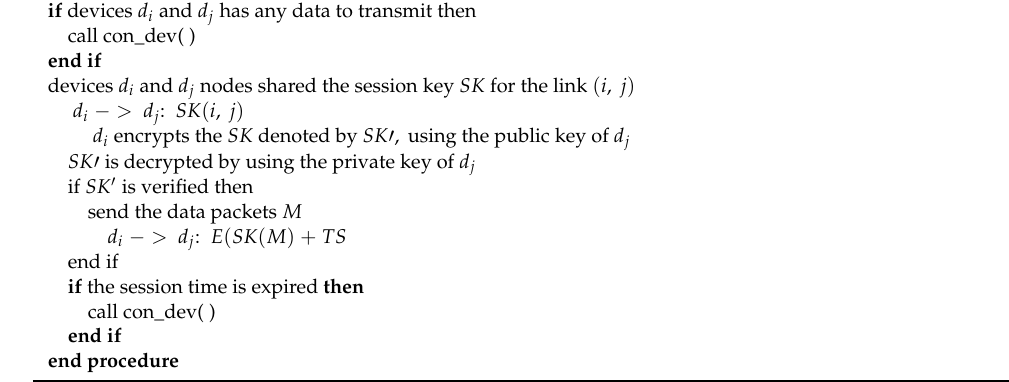
Algorithm 2 Secured network connections with a lightweight authentication scheme Procedure RLA